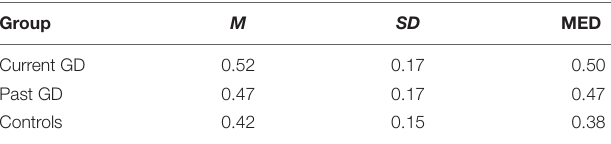
TABLE 4 | Descriptive statistics of the area under the probabilistic discounting